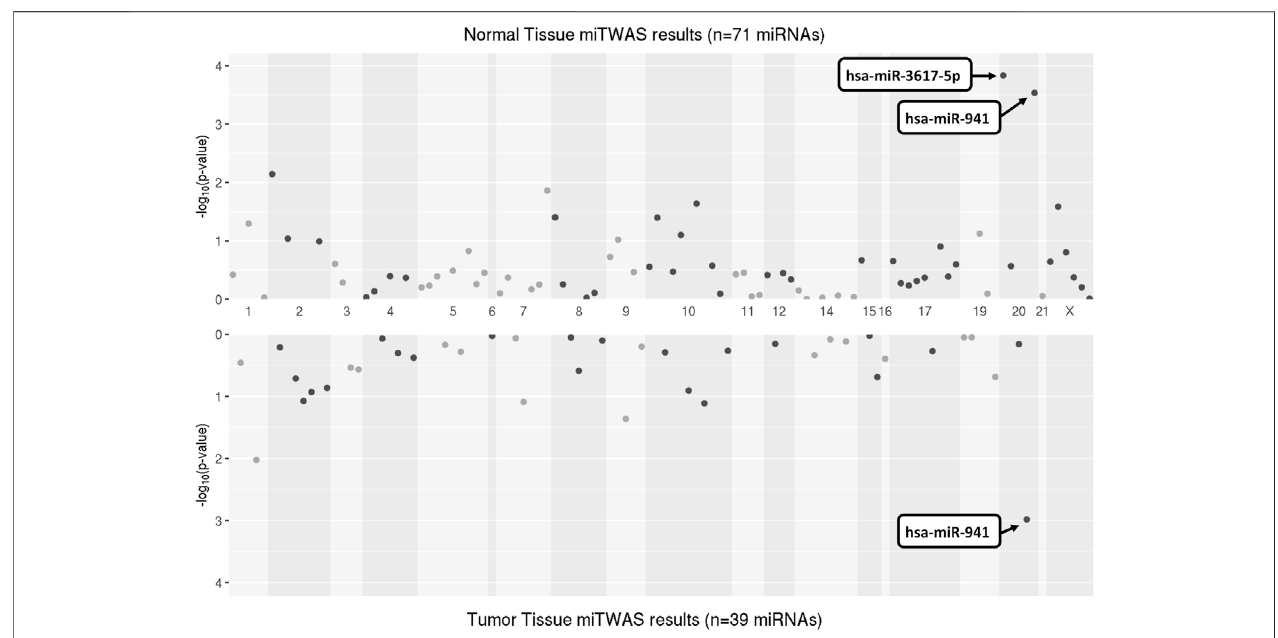
FIGURE 1 | Hudson-style plot of miTWAS results, displaying − log10(P) for miRNA GReX models trained on eQTL datasets from Mayo normal prostate tissue (top) and TCGA PRAD tumor tissue (bottom). Signi fi cant results based on FDR < 0.05 are labeled by miRNA.